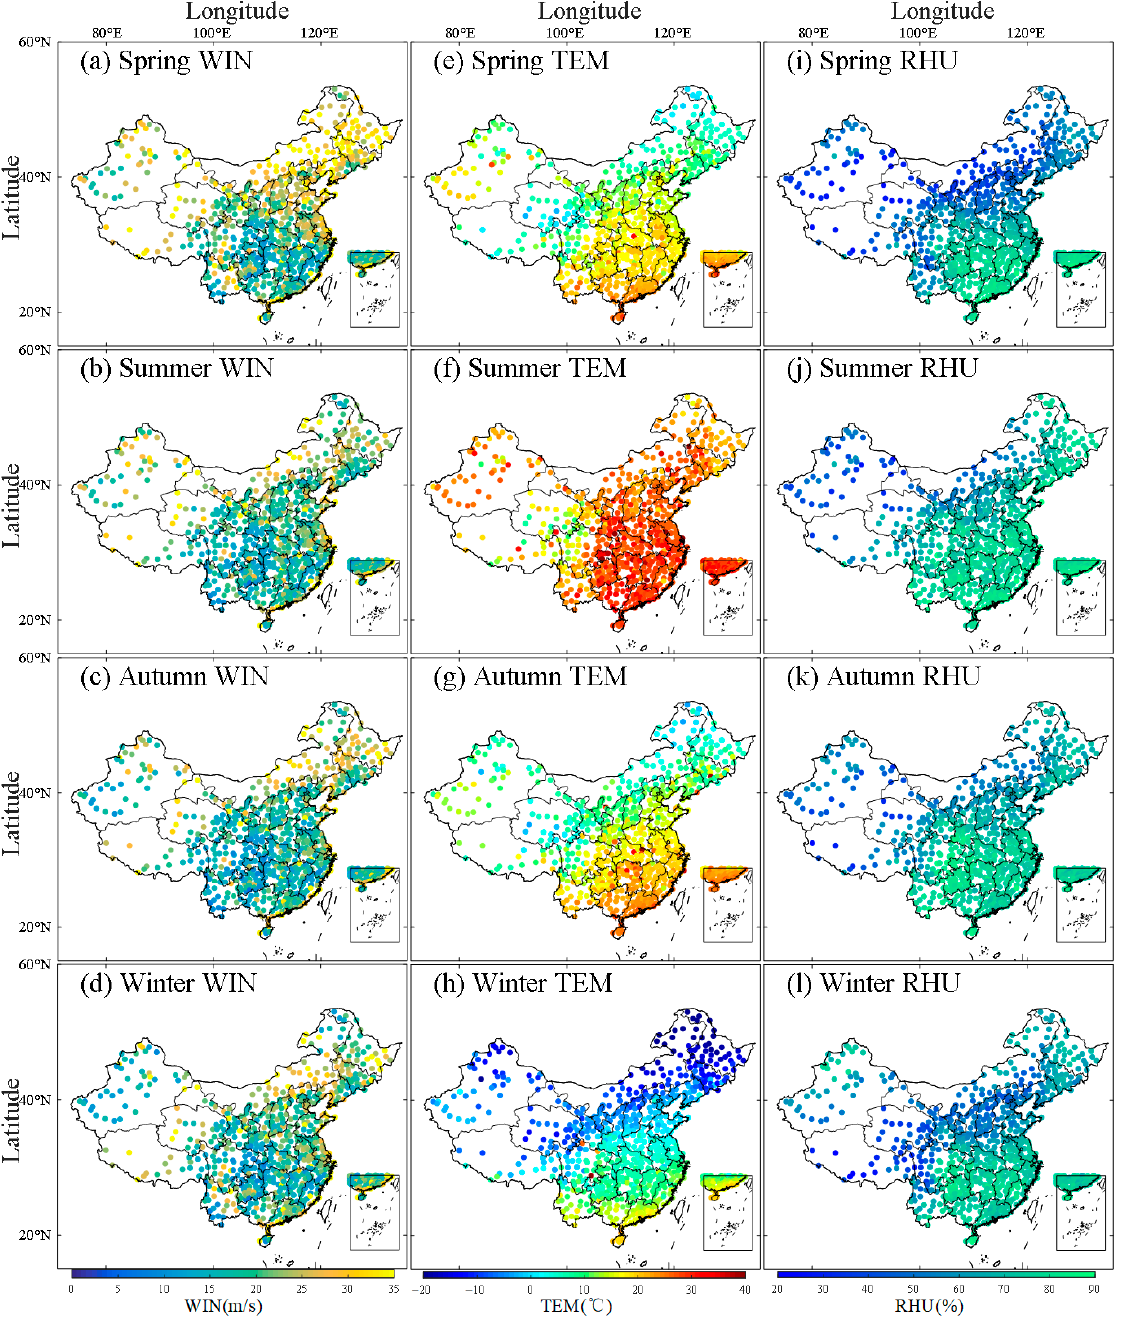
Figure 2. Seasonal averages of meteorological data from 2010 to 2020.